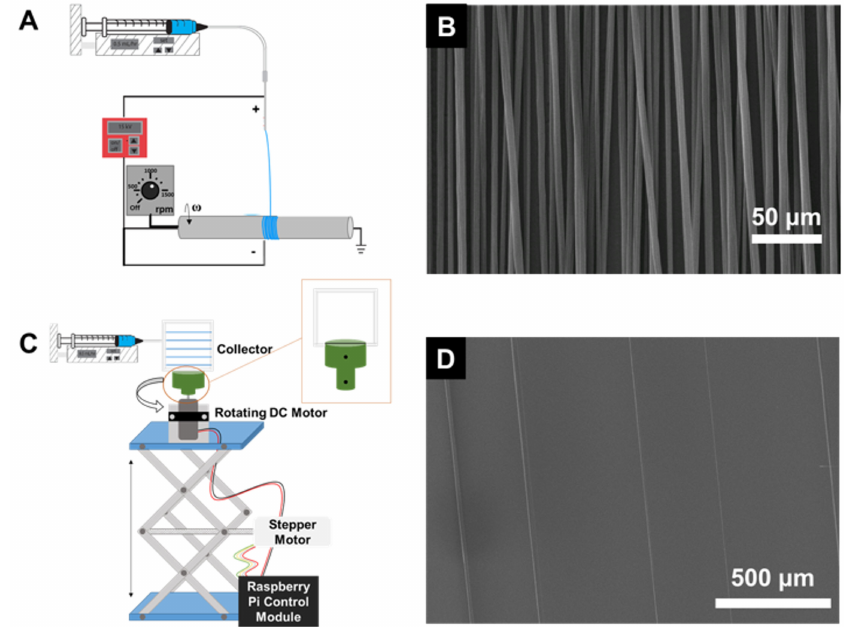
Figure 1. ( A ) Schematic for creating aligned fibers by electrospinning with a rotating mandrel. ( B ) SEM image of the aligned electrospun fibers. ( C ) Schematic for creating aligned fibers by shear force fiber spinning. ( D ) SEM image of the aligned fibers from shear force fiber